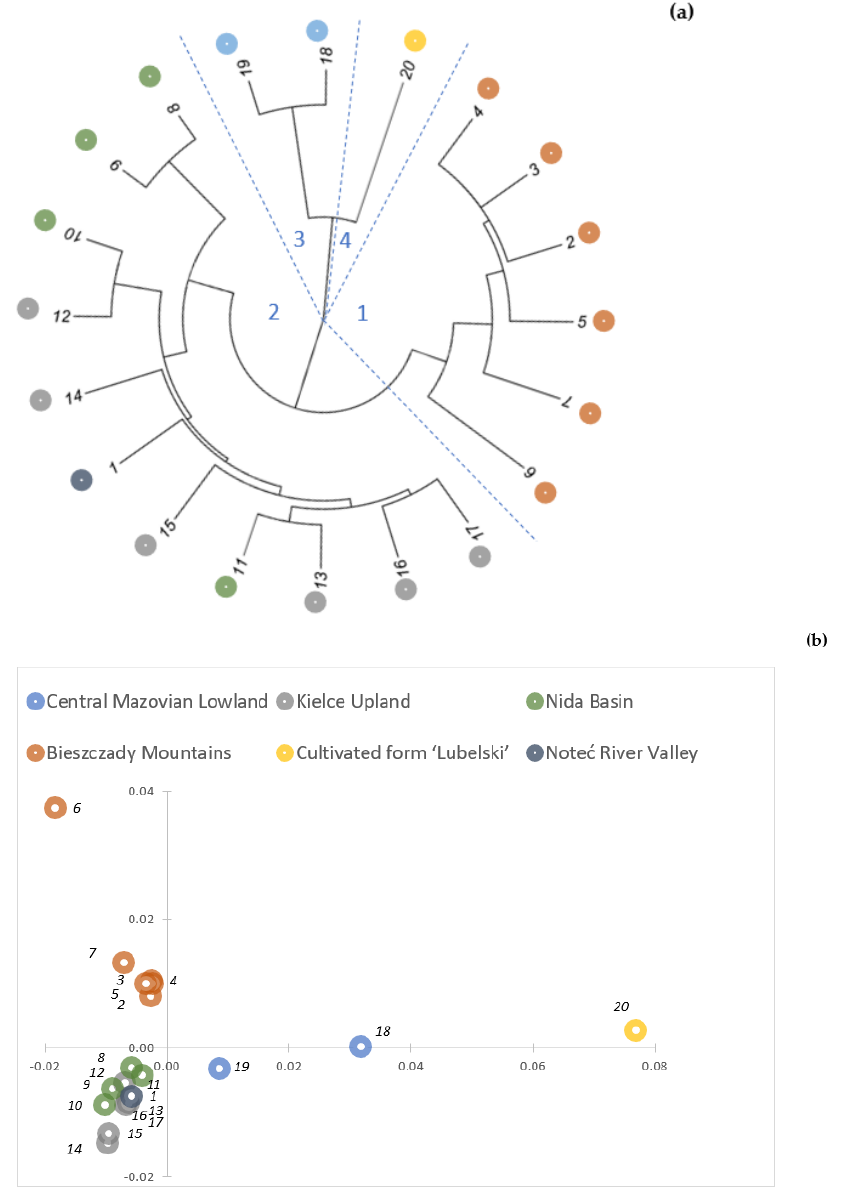
Figure 1. Genetic differentiation of 20 Valeriana officinalis accessions. ( a ) Results of the agglomerative hierarchical clustering, based on the unbiased Nei coefficient; ( b ) Results of the principal coordinate analysis for the first two PCs. The region of origin was marked with colors.